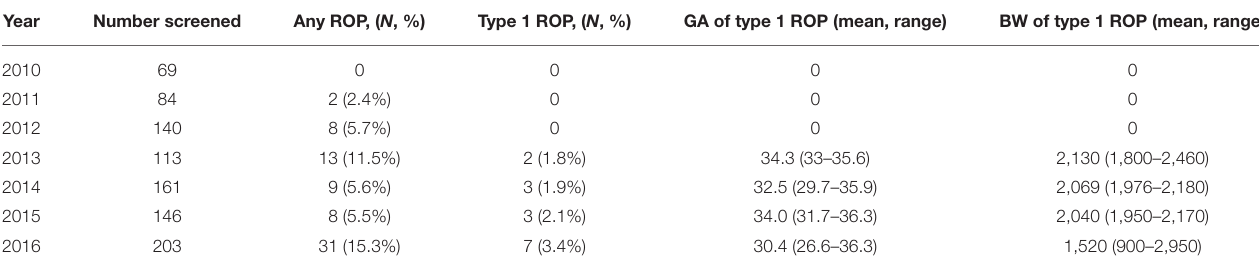
TABLE 5 | 7-year trends of type 1